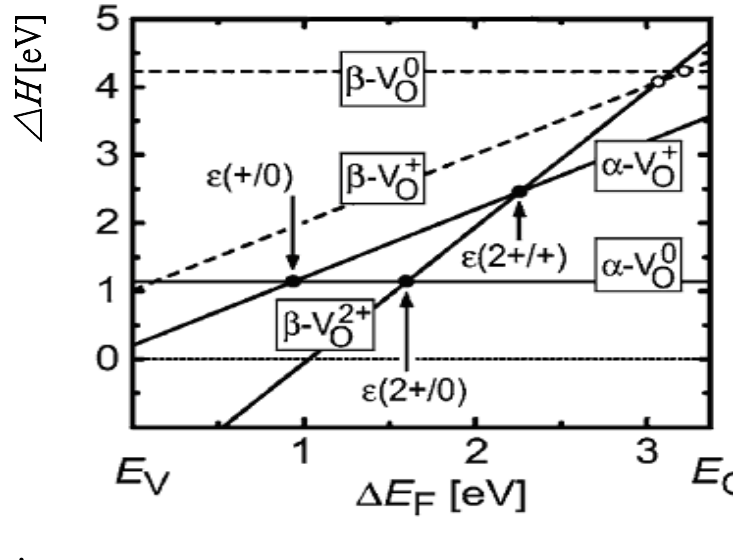
Figure 12. Formation energies of the different charge states of V closed circles show the formation and transition energies of the equilibrium stable states, respectively. Dashed lines and open circles show the formation and transition energies in the light-induced metastable configuration. Reprinted from Ref. [80] with